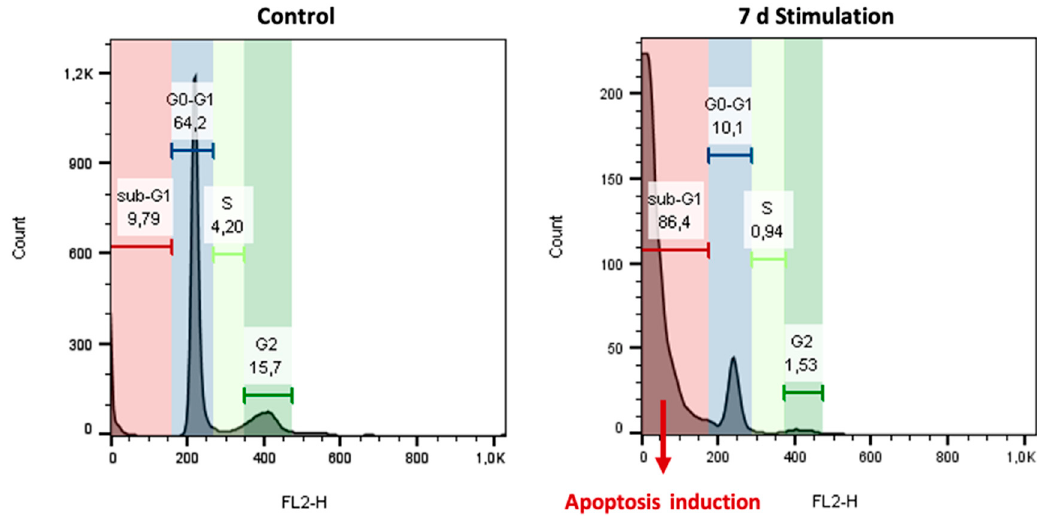
Figure 9. Analysis of the sub-G1 phase for the measurement of apoptotic cell via flow cytometry. After 7 days of electric stimulation, cell cycle analysis revealed a significant increase in the apoptotic cells.